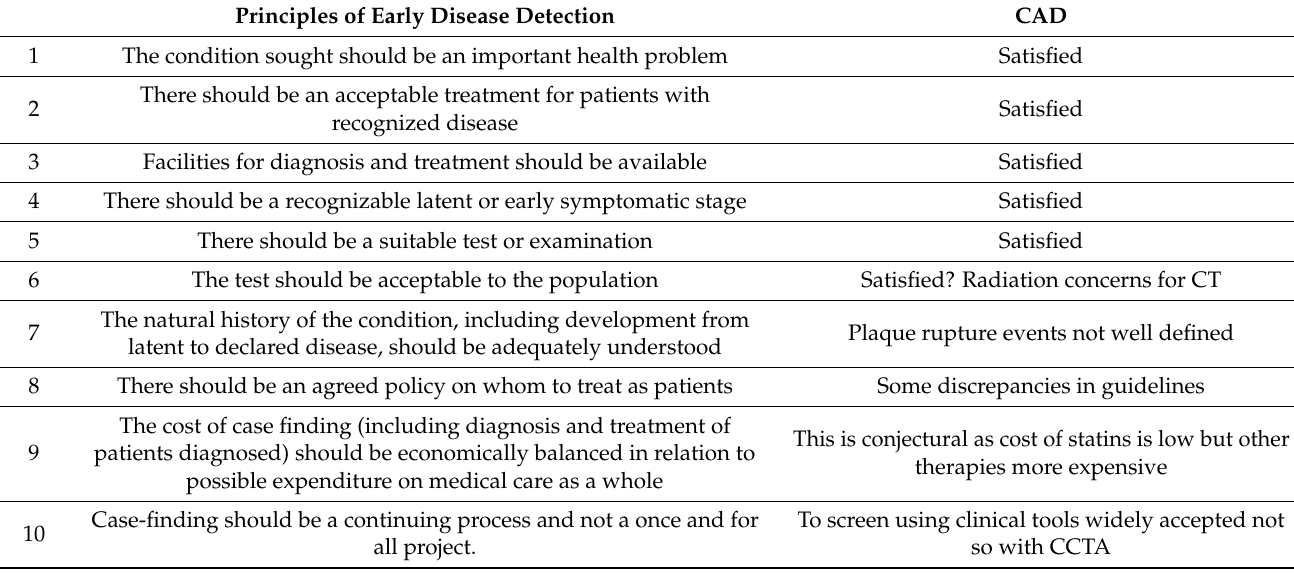
Table 2. Wilson and Junger Principles of Screening Criteria as applied to coronary artery disease